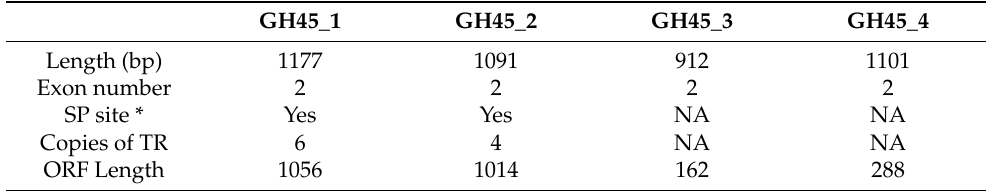
Table 1. An overview of GH45 genes with different